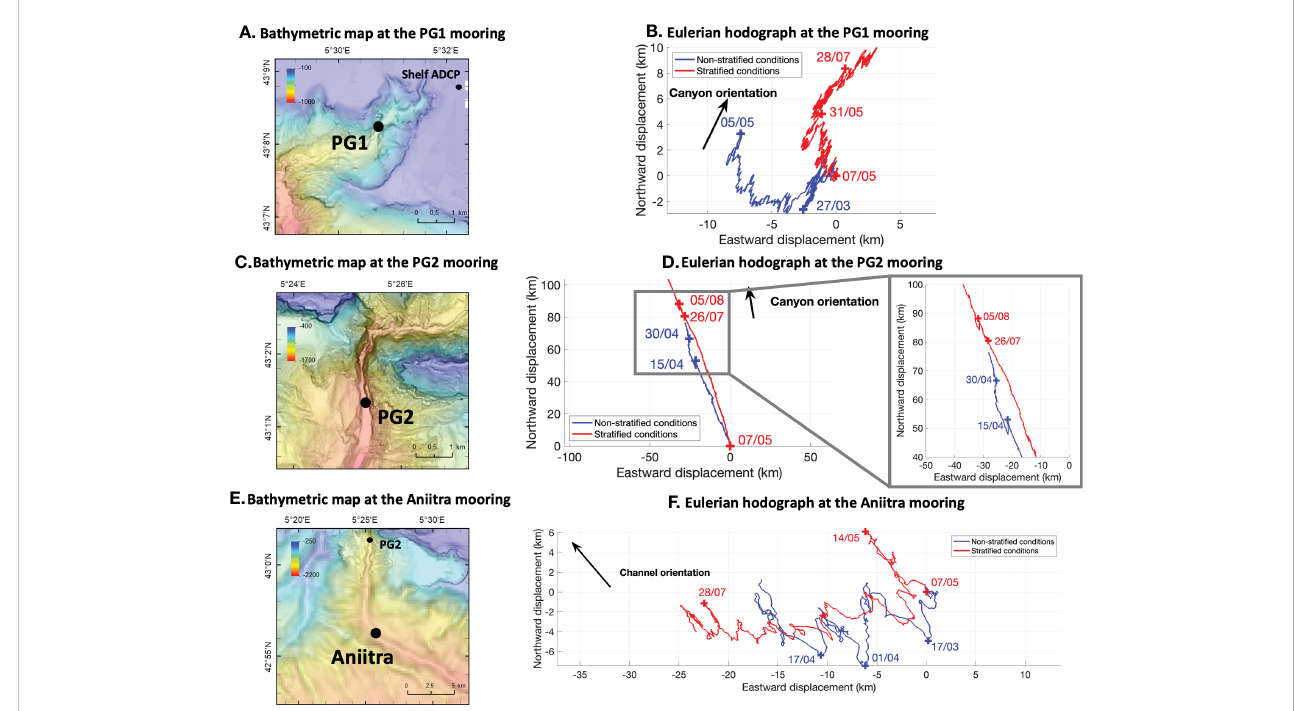
FIGURE 7 (A) Bathymetric map at the PG1 mooring (m). (B) Hodograph of the eulerian mean velocity in the bottom layer measured by the PG1 mooring. (C) Bathymetric map at the PG2 mooring (m). (D) Hodograph of the eulerian mean velocity in the bottom layer measured by the PG2 mooring and zoom on some inversion of the current direction. (E) Bathymetric map at the Aniitra mooring (m). (F) Hodograph of the eulerian mean velocity in the bottom layer measured by the Aniitra mooring. Blue lines and crosses correspond to non-strati fi ed conditions. Red lines and crosses correspond to strati fi ed